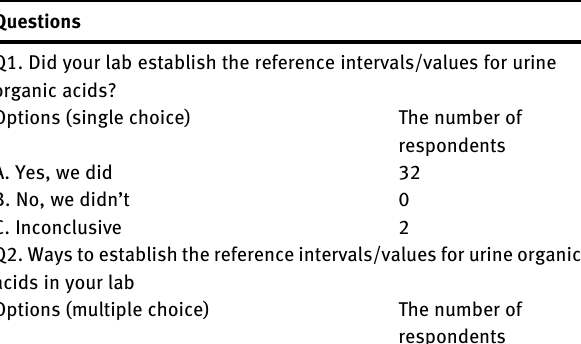
Table  : Reference intervals/values for organic acids analysis.